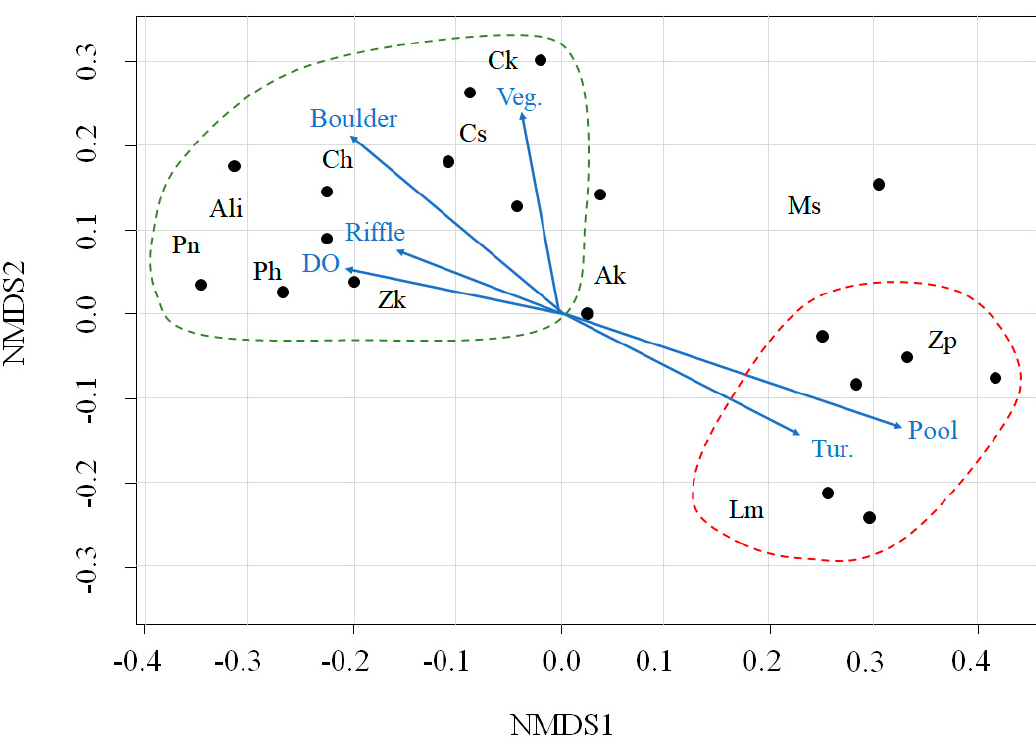
Figure 2. Non-metric multidimensional scaling (NMDS) of 11 dominant fish species (letters) and 21 study sites (dots) located in the upper parts of the Geum River. The blue arrows represent the associations with environmental variables and microhabitat patch types. The data are divided into two groups (the dashed lines marked in green color and red color). DO, dissolved oxygen; Tur., turbidity; Veg., vegetated area; Ak, Acheilognathus koreensis ; Ali, Acheilognathus lanceolata intermedia ; Cs, Coreoleuciscus splendidus ; Pn, Pseudopungtungia nigra ; Ph, Pungtungia herzi ; Zk, Zacco koreanus ; Zp, Zacco platypus ; Lm, Lepomis macrochirus ; Ms, Micropterus salmoides ; Ch, Coreoperca herzi , Ck, Coreoperca kawamebari .